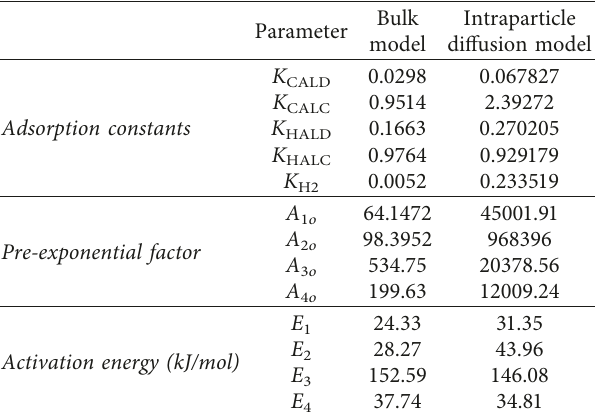
Table 4: Predicted kinetic